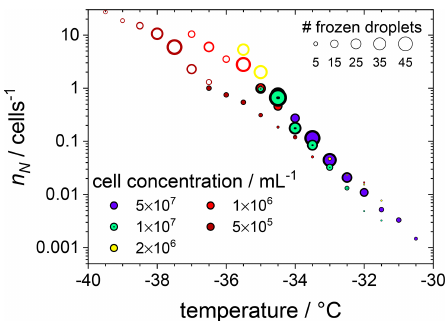
Figure 3. The cumulative number of ice nucleating sites n N per number of F. cylindrus diatom cells as a function of temperature, obtained from the data shown in Fig. 2a with the help of Eq. (S9). The original data were binned into intervals of 0.5 ◦ C. The size of the symbols indicates the absolute number of droplets frozen in a particular bin, and the cell concentrations (in mL − 1 ) are indicated by colour. The filled circles represent the droplets that contain whole F. cylindrus cells, while Poisson statistics suggest that the open cir- cles should not contain any intact diatoms but probably some cell fragments (see